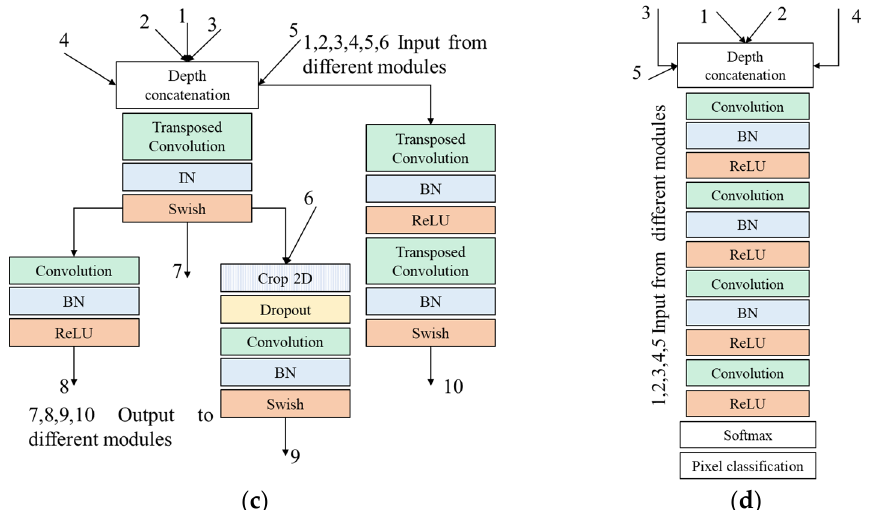
Figure 3. Examples of the multi-branch architecture in different depths of the network: ( a ) shallow depth (encoding layer); ( b ) middle depth (decoding layer); ( c ) deep depth (decoding layer) ; ( d ) deep depth (classification layer) .